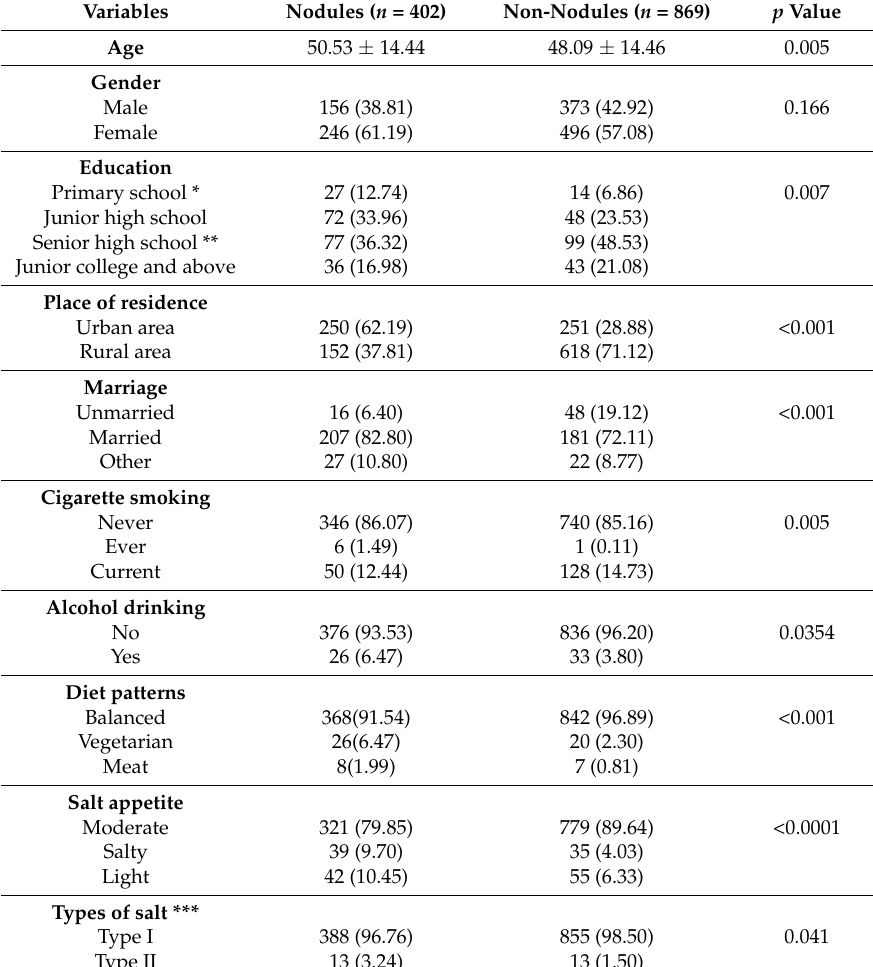
Table 1. The distributions of sociodemographic characteristics among patients with and without thyroid